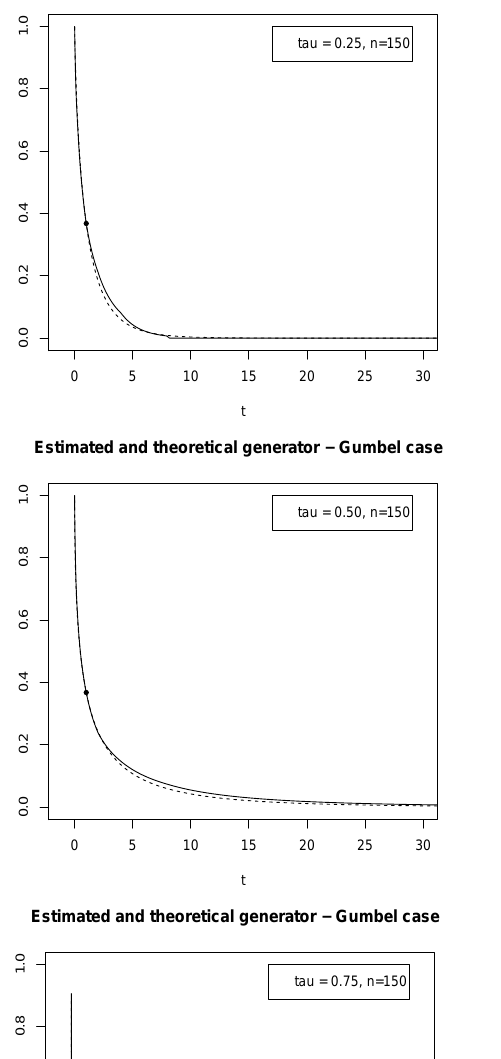
= 0 . 25 , 0 . 5 and 0 . 75 . Size of simulated samples n = 150 (left column) as in Definition 4.4 (full line). The theoretical standardized Gumbel-generator, y ( t ) ( 0 )